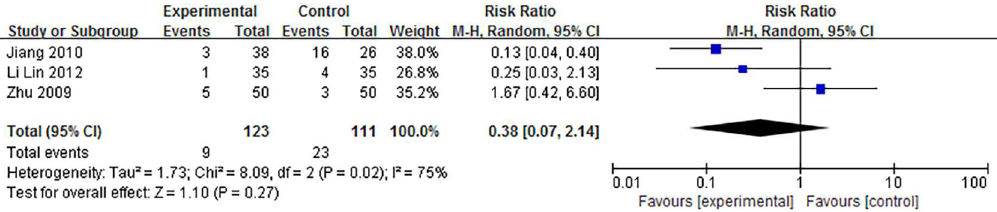
Fig 6. Forest plot of relapse rate of SMT-treated FD between experimental and control group. SMT = Si-Mo- Tang oral liquid, FD = functionaldyspepsia.